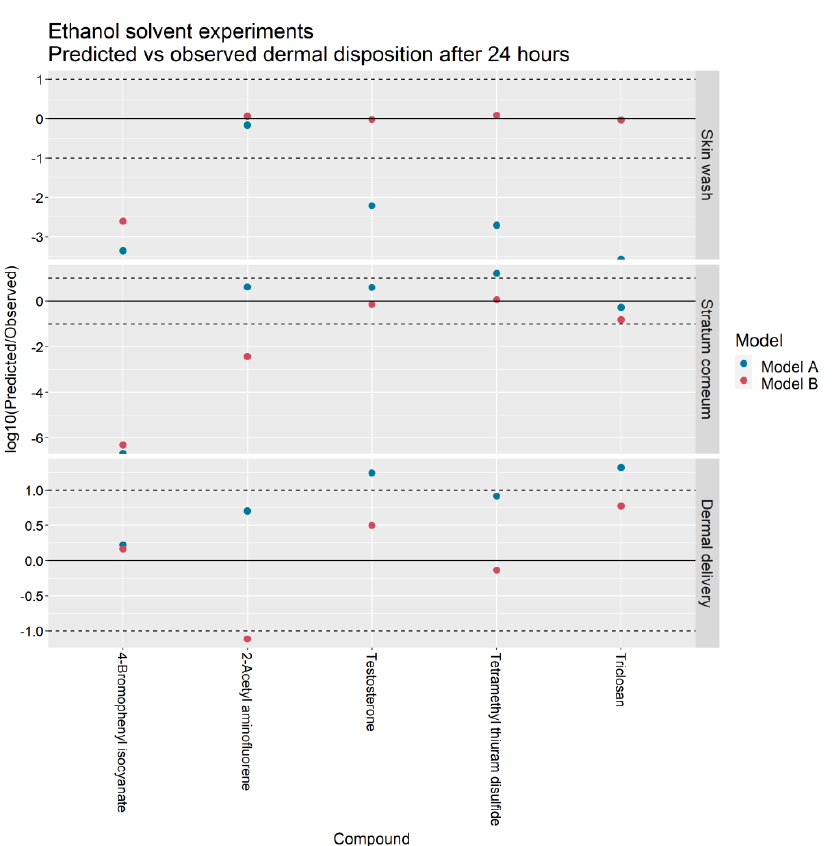
Figure 5. Predicted vs. observed skin wash, stratum corneum accumulation and dermal delivery in IVPTs conducted in an ethanol solvent for Models A and B. Points between the dashed lines indicate predictions that are within one order of magnitude of observations.